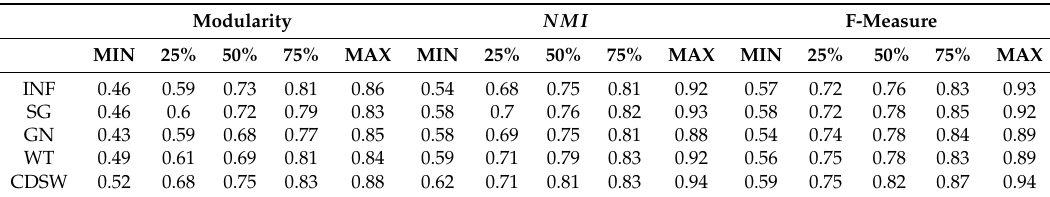
Table 3. Box plot statistics for modularity, NMI and F-measure.